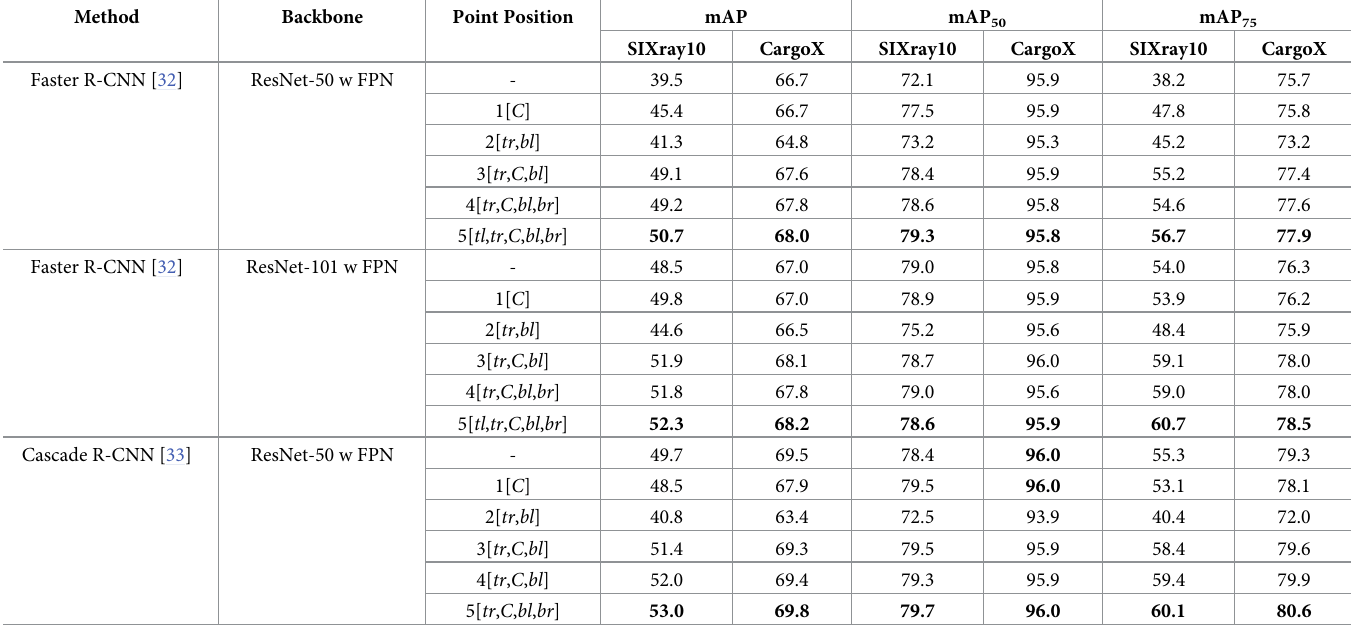
Table 4. Effect of the position of the point in the point head Module. Method Faster R-CNN